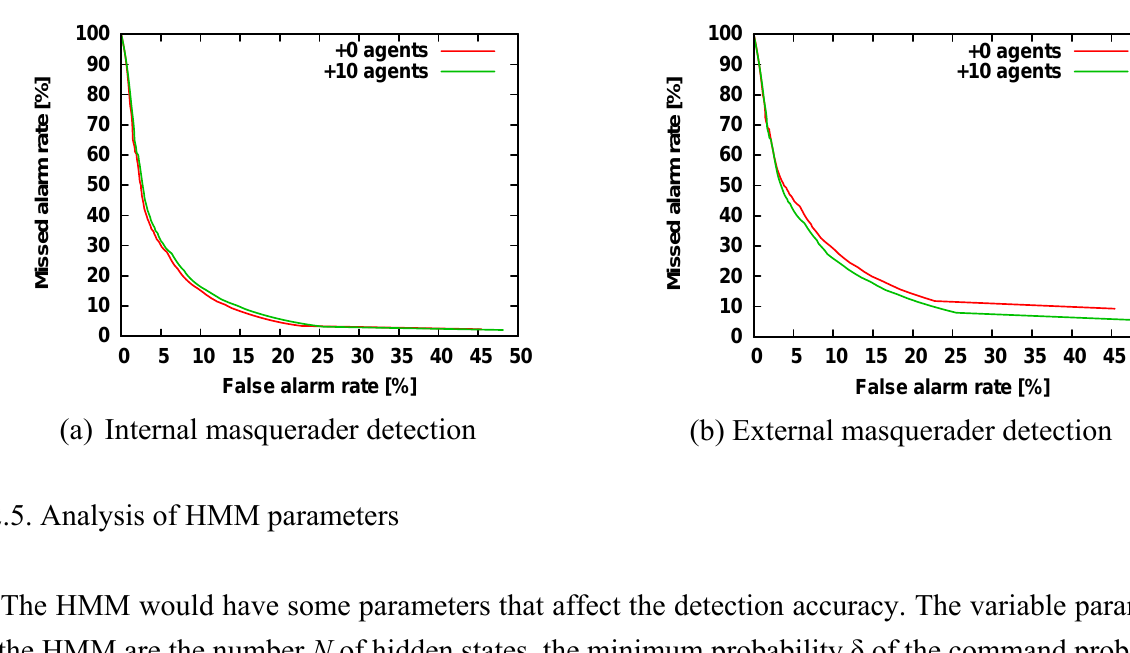
Figure 7. ROC curves of internal masquerader detection (a) and external masquerader detection (b) for 10 external user-specific agents and no additional agents. The parameters are as follows: N int = 10, N ext = 10. All other parameters are the same as those in Figure 3. The length of the command sequences generated by the base HMM is the same as that in the training data. The number of command sequences is